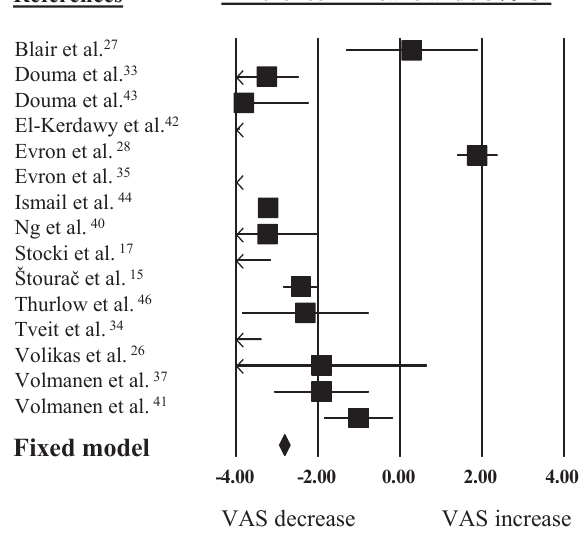
Fig. 2. Meta-analysis for VAS change in first 60 minutes of remifentanil analgesia.